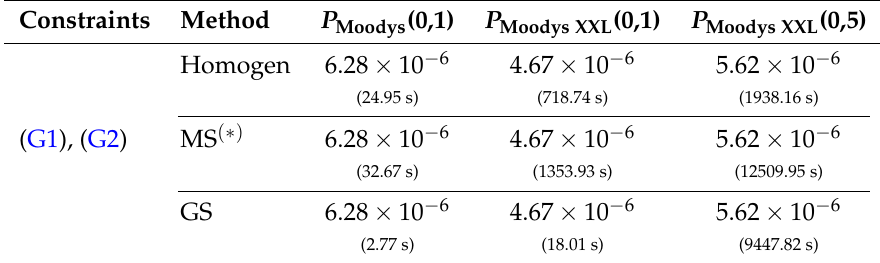
Table 2. Comparison of global solutions based on the averaged Frobenius norm and Constraints (G1), (G2) with starting point X DMPG , for given transition matrices from Moodys in Table A1 (* the MS 0 method uses a set of 100 different start points, which are parallelized).